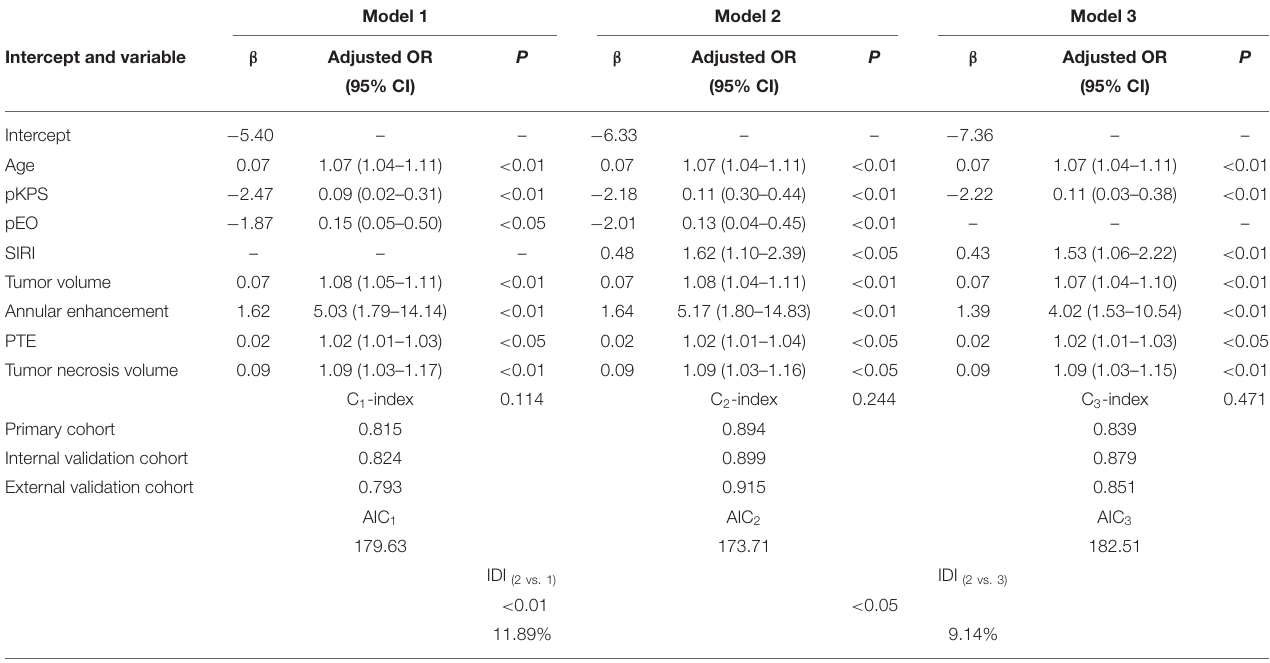
TABLE 2 | Risk factors for GBM in primary